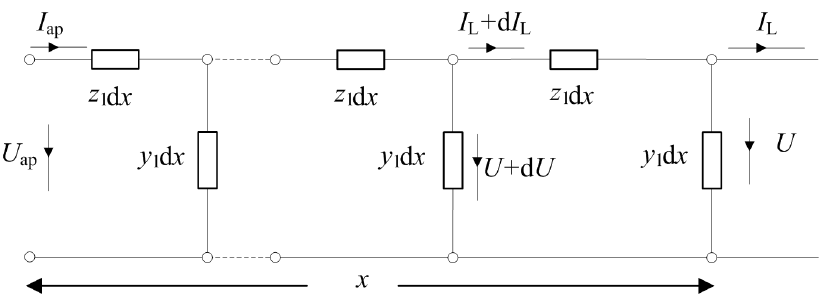
Figure 5. Equivalent distributed parameter electrical circuit of the arc